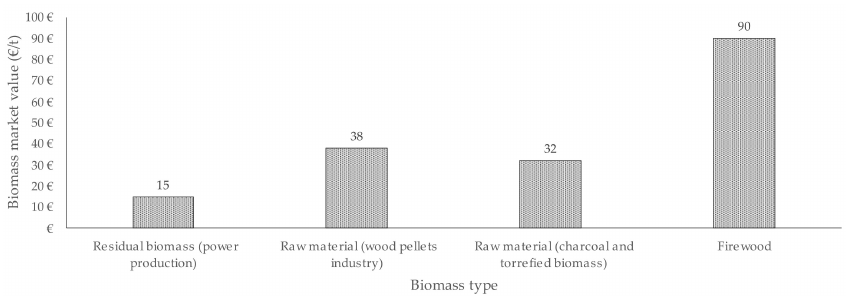
Figure 6. Biomass average market prices in Portugal for other species than maritime pine and